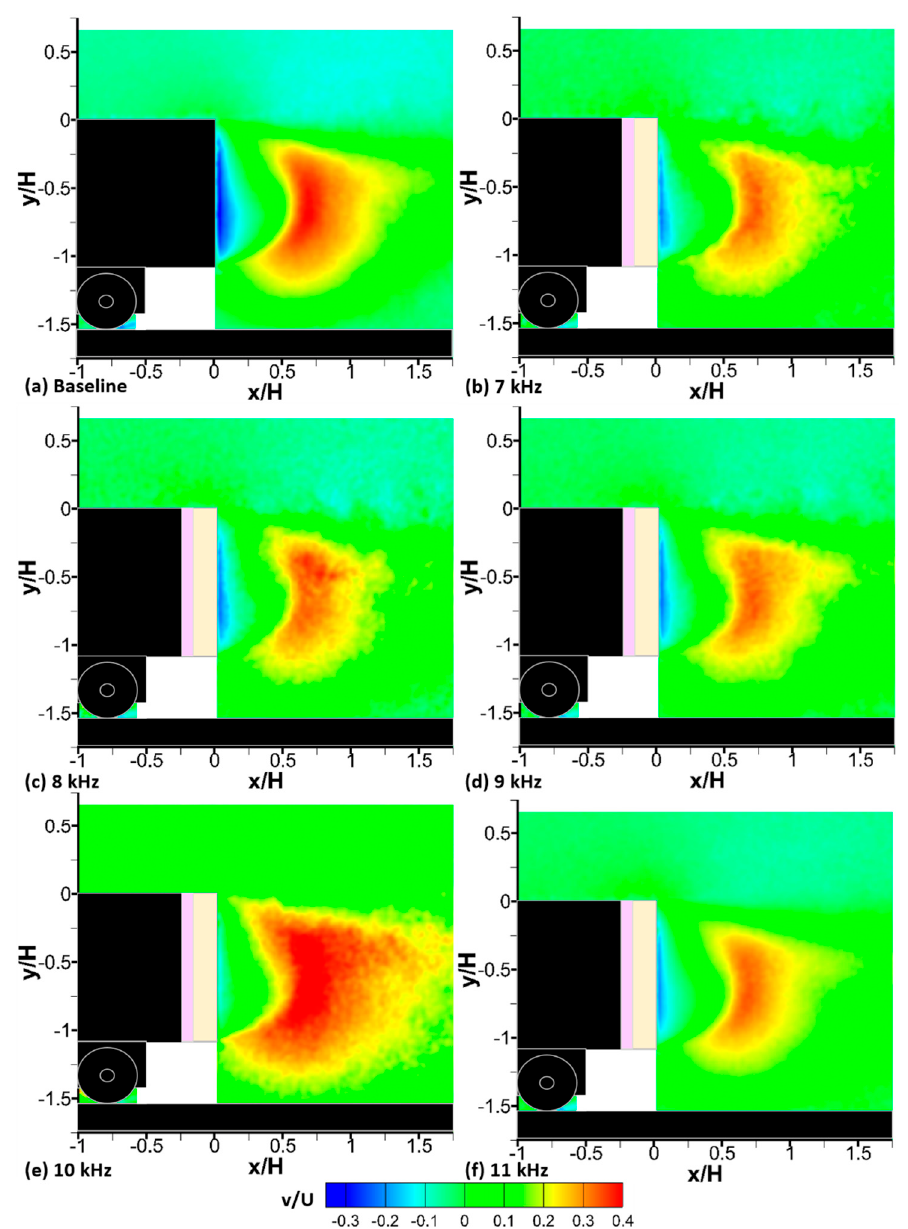
Figure 12. Normalised y-velocity contour downstream of the trailer rear end at various plasma actuation frequencies. ( a ) Baseline, ( b ) 7 kHz, ( c ) 8 kHz, ( d ) 9 kHz, ( e ) 10 kHz, and ( f ) 11 kHz.